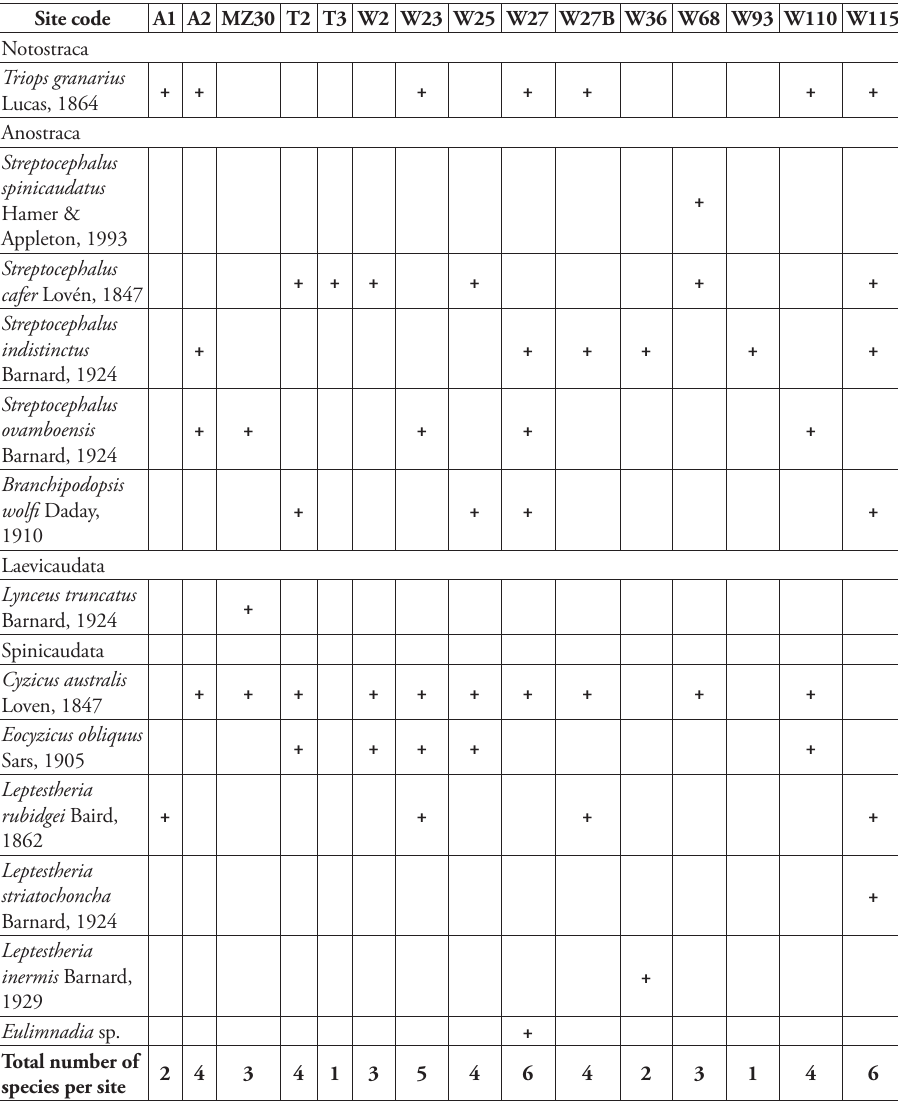
Table 1. Large branchiopod species collected from 15 waterbodies of the Eastern Cape Karoo sampled in November 2014 and April 2015. See Supplementary file 1: Appendix 1 for full locality information for each site